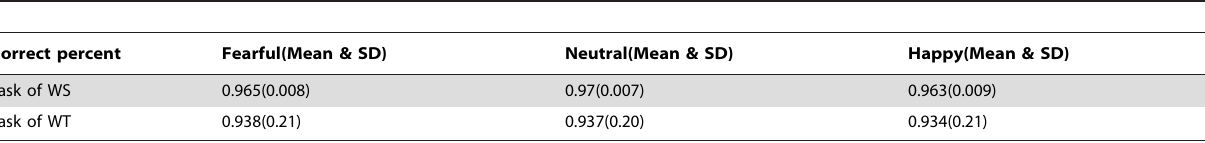
Table 4. Means and standard deviations of the correct percentage (1= 100%) in Experiment 2 for the word structure and word tone judgment tasks when fearful, neutral and happy faces were unattended respectively.